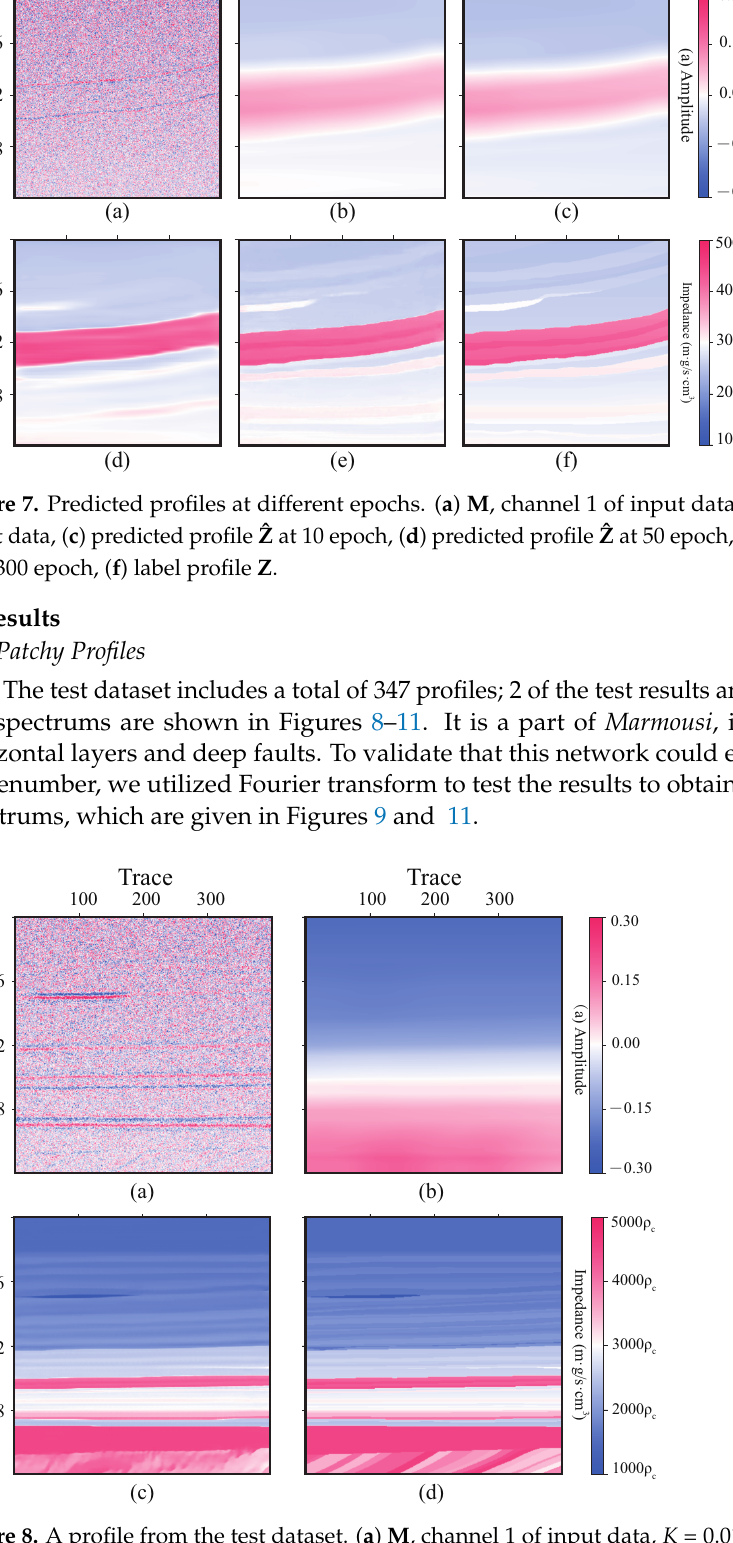
Figure 8. A profile from the test dataset. ( a ) M , channel 1 of input data, K = 0.015, SNR = − 4.72 dB, P = 10 ◦ , ( b ) B , channel 2 of input data, ( c ) predicted profile ˆZ , PCC = 0.9924, R 2 = 0.8393, SSIM = 0.8984, PSNR = 27.71 dB. ( d ) label profile Z